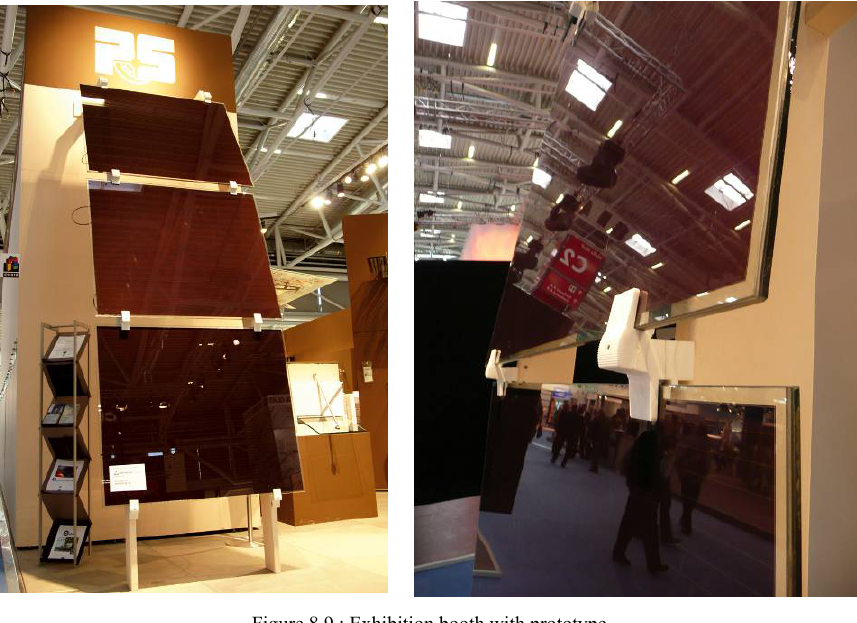
Figure 8,9 : Exhibition booth with prototype